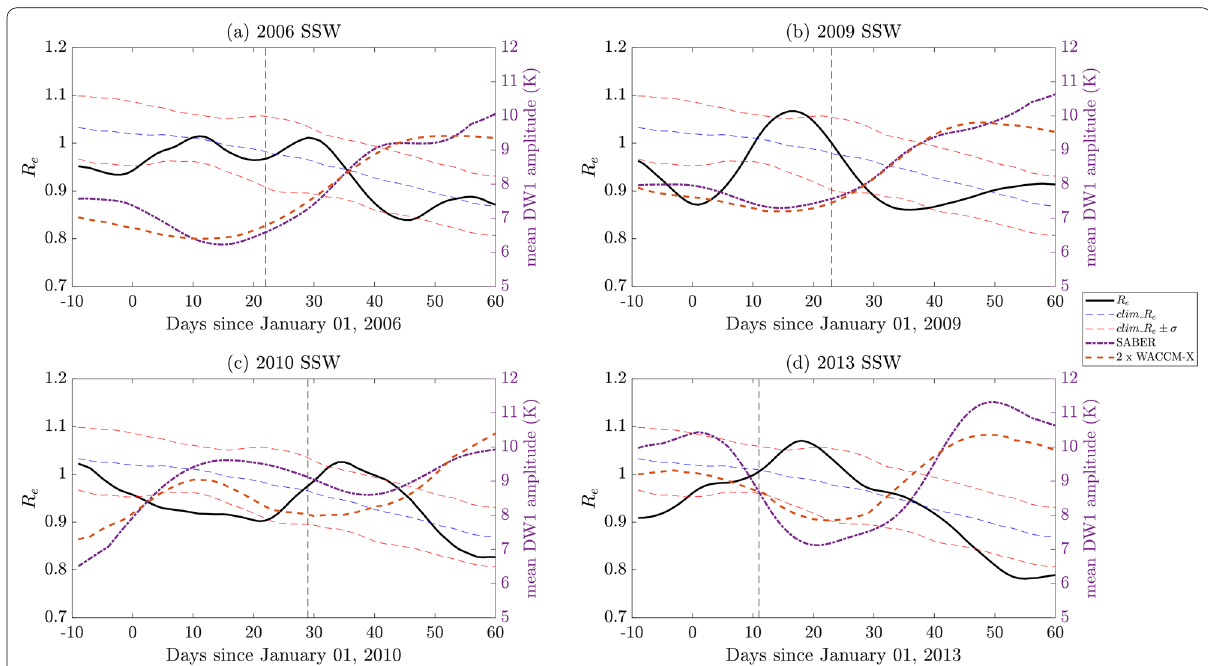
Fig. 6 The left y-axes in this figure show the temporal evolution of R e (black solid lines) during (a) 2006, (b) 2009, (c) 2010 and (d) 2013 NH SSWs while the right y-axes show the mean DW1 tidal amplitudes from SABER (purple dashed-dotted lines) and SD-WACCM-X (brown dashed lines) that are averaged between 30 S and 30 N at 90 km altitude. For comparison, the mean DW1 tidal amplitudes from SD-WACCM-X are scaled up by a factor of 2. The blue dotted lines show the climatological values of R e (clim_ R e ) and the red dotted lines mark the standard deviation associated with clim_ R e at 2 σ ±